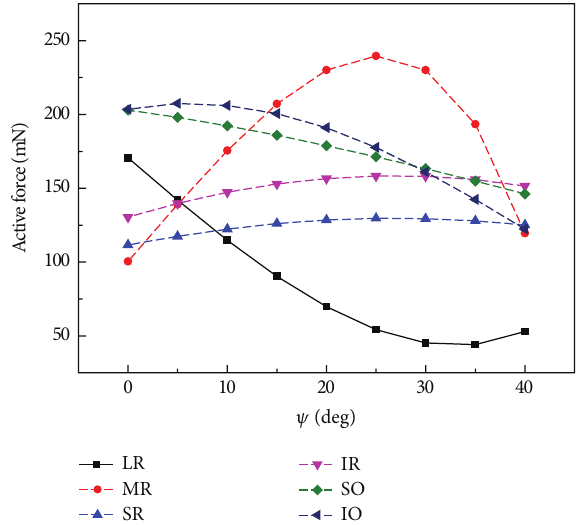
Figure 4: Comparison of resistance forces from the other four EOMs, except for the horizontal recti, during passive rotation of the eye in the primary innervations (note: the experimental data are adopted from Figure 27 of reference [12]).